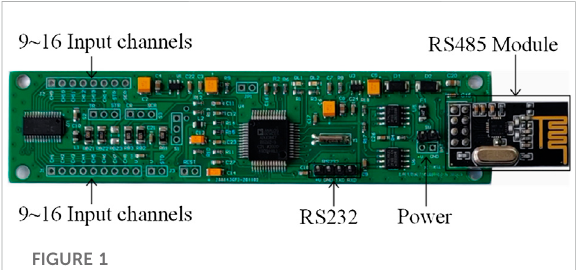
FIGURE 1 Circuit board of the logging system of the CSIRO method with dual temperature compensation.